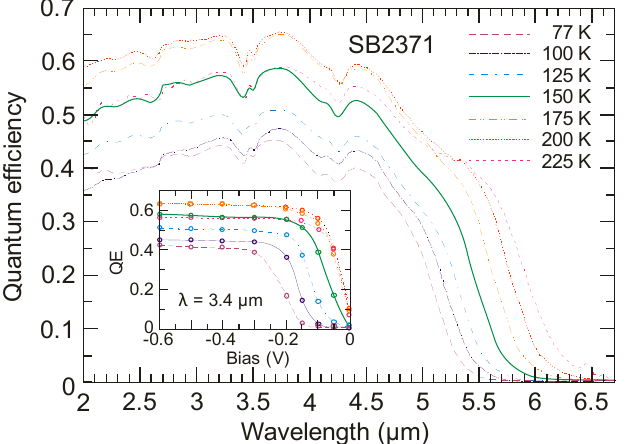
Figure 63. BSI spectral QE for MWIR detector for temperatures ranging from 77 to 225 K. The inset shows the QE measured at 3.4 μ m versus voltage at the same set of temperatures [171].